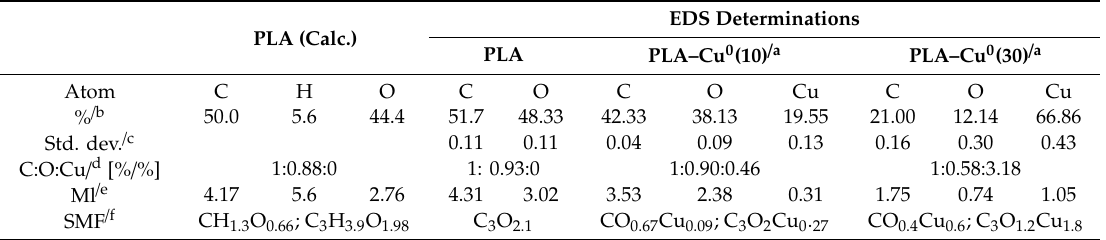
Table 3 . Energy-dispersive spectroscopy ( EDS) analysis results of PLA and PLA–Cu 0 (t). Table 3. Energy-dispersive spectroscopy (EDS) analysis results of PLA and PLA–Cu 0 (t). PLA (Calc.) PLA